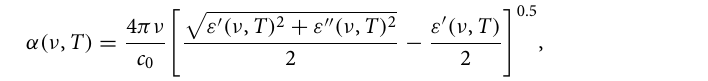
Figure 2. Temperature distributions of water for a single THz pulse. ( a ) Radial (at z r 0 ) temperature dependencies at various time instants. Spatial temperature distribution ( c ) at the end = of the THz pulse ( E ∗ THz f p 100 Hz = [ ]